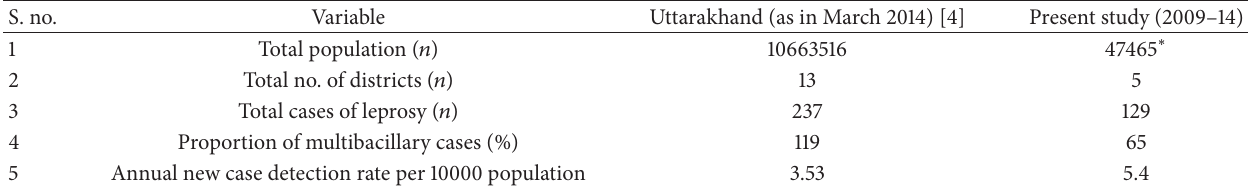
Table 4: Statistics of leprosy in Uttarakhand as in March 2014 [4] compared with present